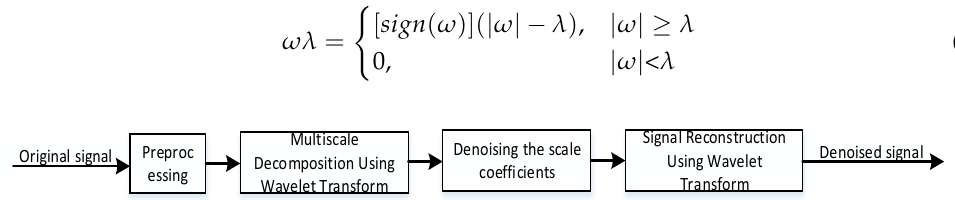
Figure 1. Schematic diagram of wavelet threshold denoising.